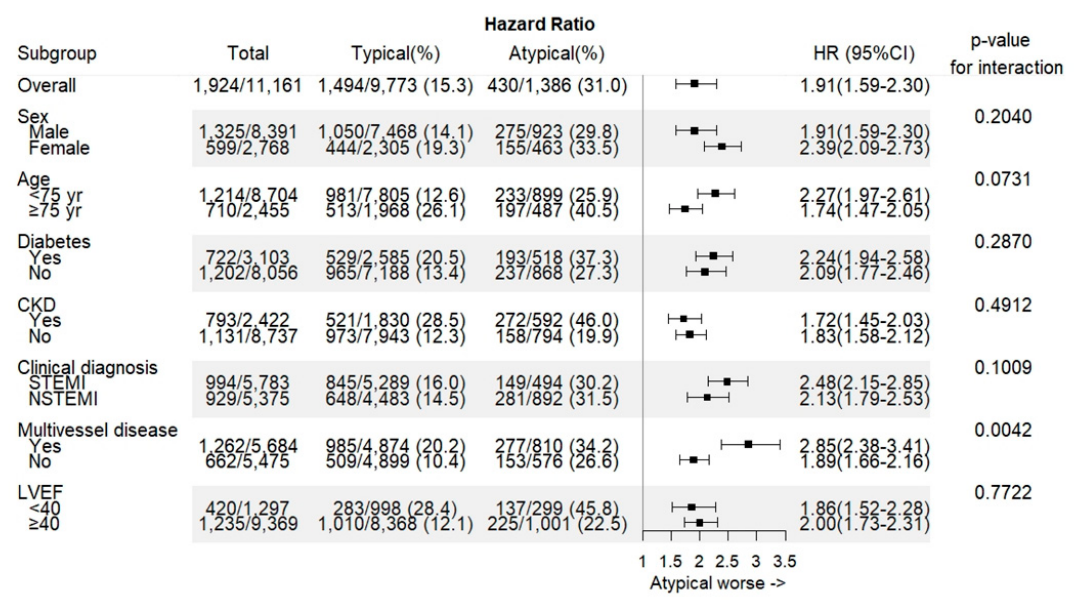
Figure 4. The primary outcome in the subgroup of interest. CKD, chronic kidney disease; STEMI, ST-segment elevation myocardial infarction; LVEF, left ventricular ejection fraction.